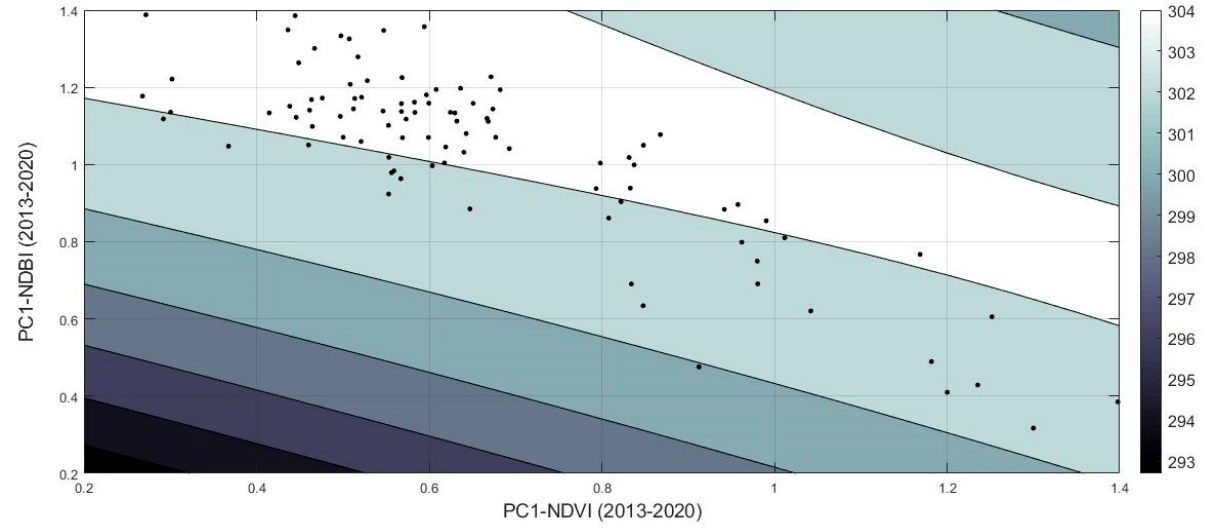
Figure 14. Second-order polynomial model for the estimation of the mean temperature over the Strovolos case study, using the first principal component of the NDVI in the X -axis and the first principal component of the NDBI in the Y -axis.